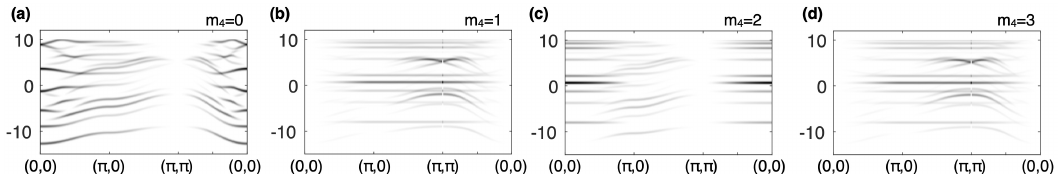
and 4 = 11 was used. We max